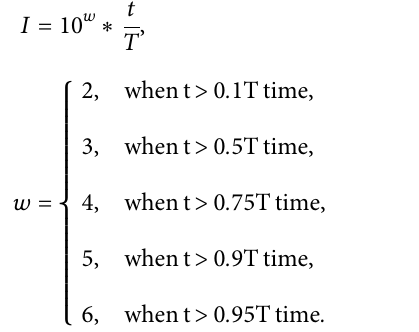
Figure 1: The graph of the energy efficiency summation of D2D users as a change of the population size n . Figure 2: The graph of D2D user energy efficiency summation as a change of the number of D2D user pairs (dimension) d .